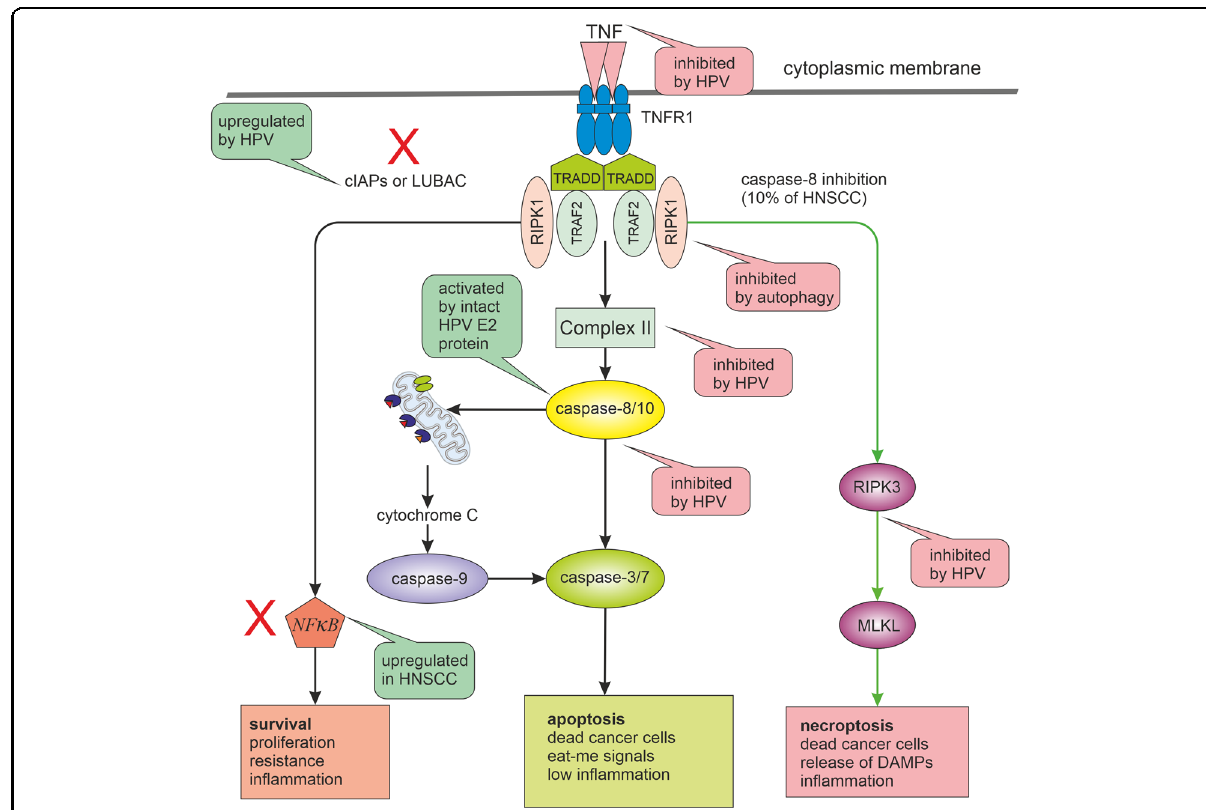
Fig. 1 Alternative pathways of TNF signalling and their alterations in HNSCC. TNF signalling can lead to different results. It depends on the post-translational modi fi cation and activation of key molecules such as caspase-8, RIPK1 and NF- κ B. While active caspase-8 triggers apoptosis and suppresses necroptosis, its inactivity (e.g. by mutations) leads to necroptosis through RIPK3 activation. If the RIPK1 signal is modi fi ed by the addition of ubiquitin, cell death can be attenuated, and the cell receives a signal for survival and proliferation by the transcription factor NF- κ B. NF- κ B pathway inhibitors such as LUBAC inhibitors or SMAC mimetics can sensitise HNSCC cells to necroptosis or apoptosis. For successful anticancer treatment response, the pathway marked by red exes should be inhibited (inhibition of autophagy should be also bene fi cial for necroptosis triggering). The TNF signalling pathways are also signi fi cantly in fl uenced by HPV infection and by the genetic background of HNSCC. Green bubbles indicate activation and pink inhibition of the process. LUBAC linear ubiquitin chain assembly complex, c-IAPs inhibitors of apoptosis, RIPK receptor-interacting serine/ threonine – protein kinases, MLKL mixed lineage kinase domain-like